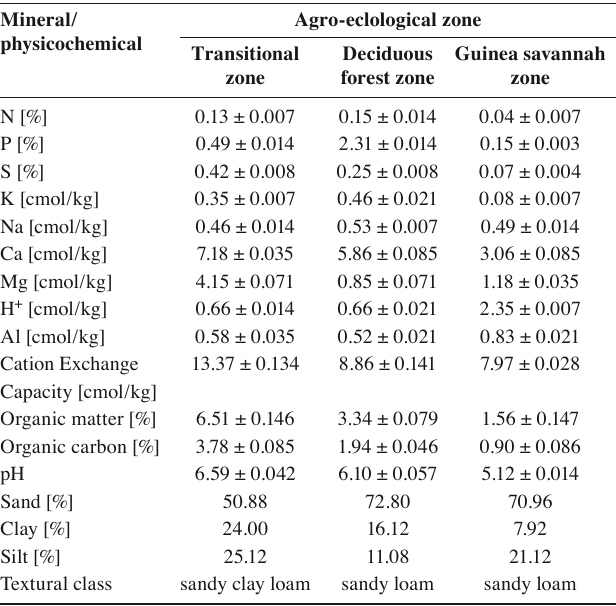
Tab. 3: Soil composition of the three experimental fields prior to the cultiva- tion of Moringa oleifera accessions (mean ± standard deviation ).